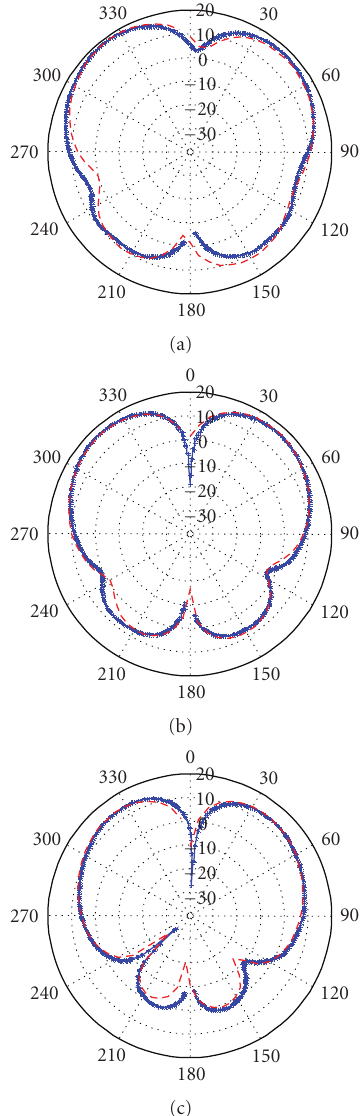
Figure 6: Measured (+) and simulated ( − ) copolarized radiation patterns for conical mode ( S 22) in XZ plane at (a) 1.7 GHz, (b) 1.85 GHz, and (c) 2.1